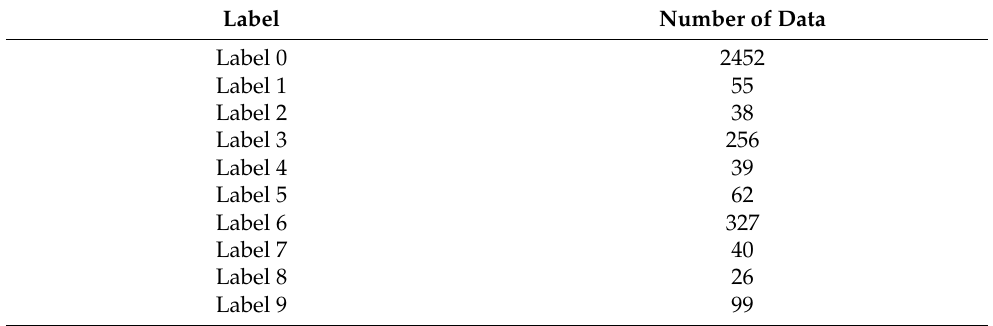
Table 3. Data set